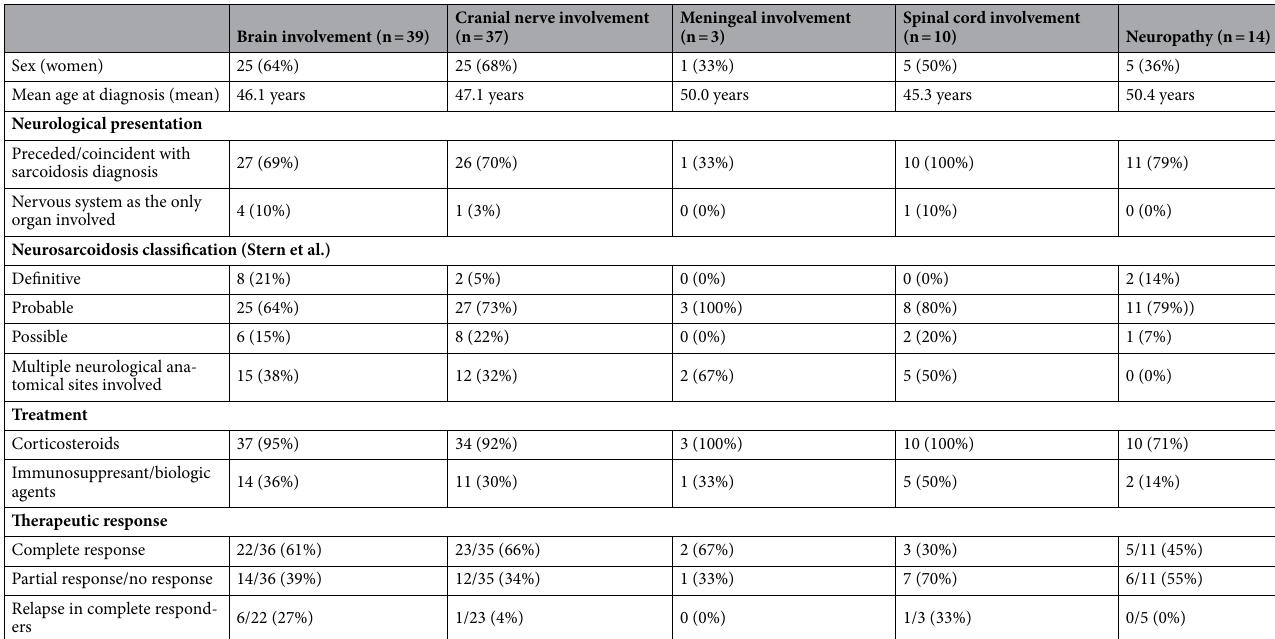
Table 2. Demographics and therapeutic information of patients with neurosarcoidosis according to the different anatomical